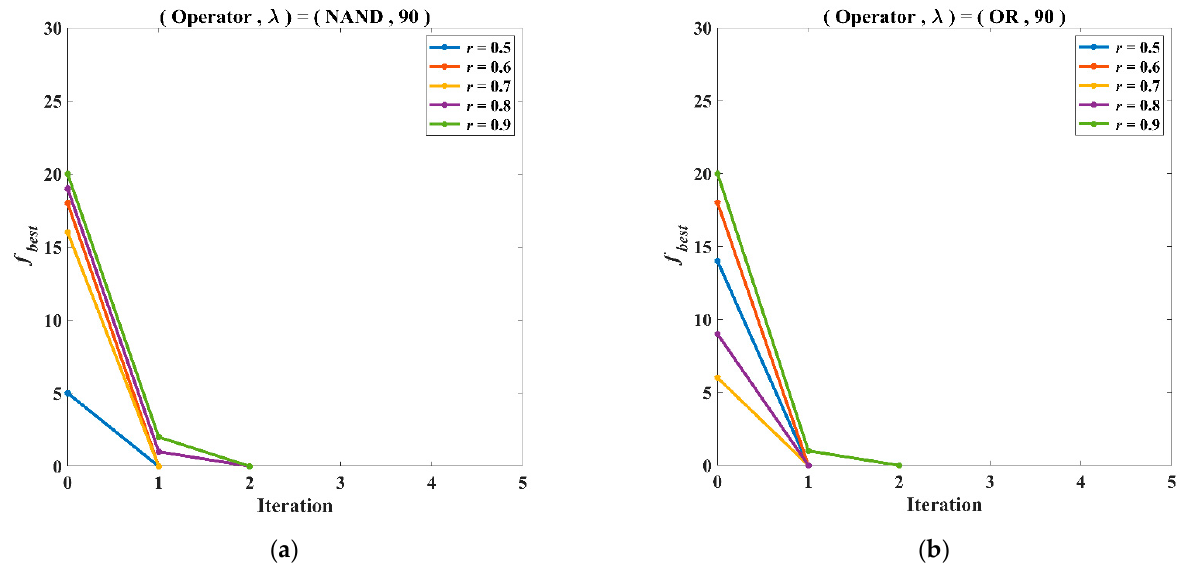
Figure 5. ( a ) f best for r 2SAT nand − ABC , ( b ) f best for r 2SAT or − ABC Figure 5. ( a ) best f for − 2SAT nand ABC r , ( b ) best f for − 2SAT or ABC r .